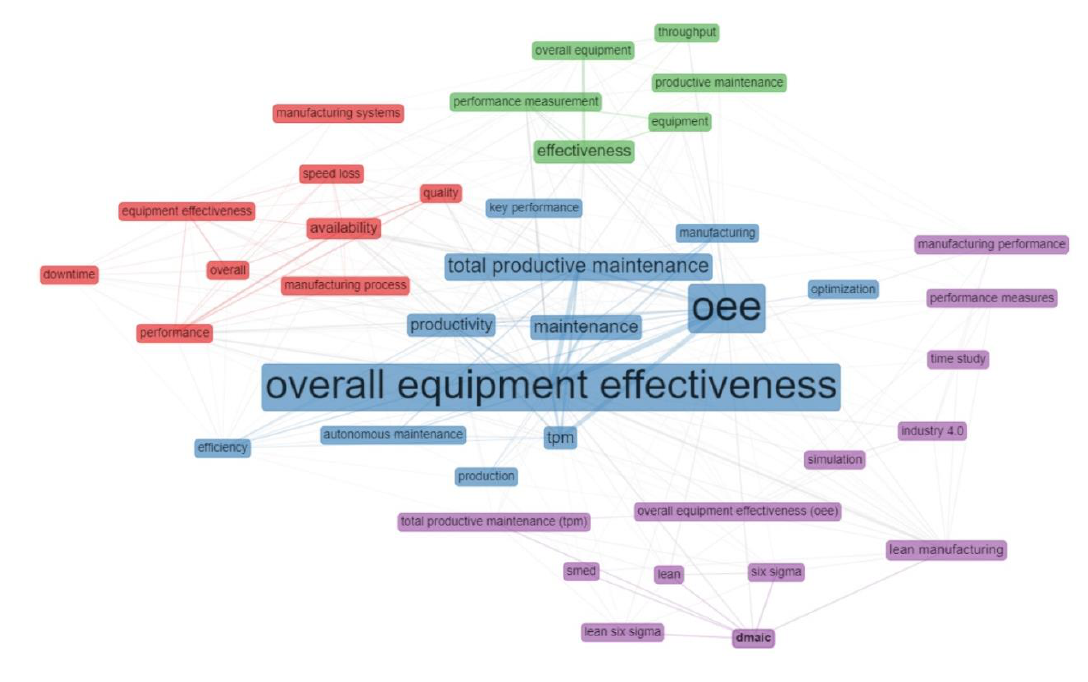
Figure 5. Co-occurrence